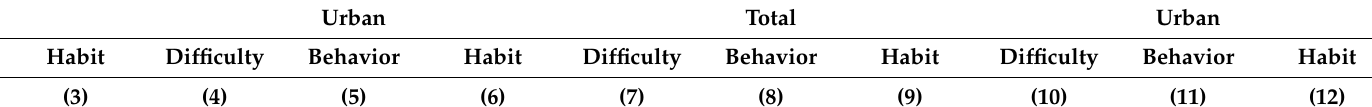
Table A2. Probit model of the impact of cultural consumption on waste separation behavior and difficulty of waste